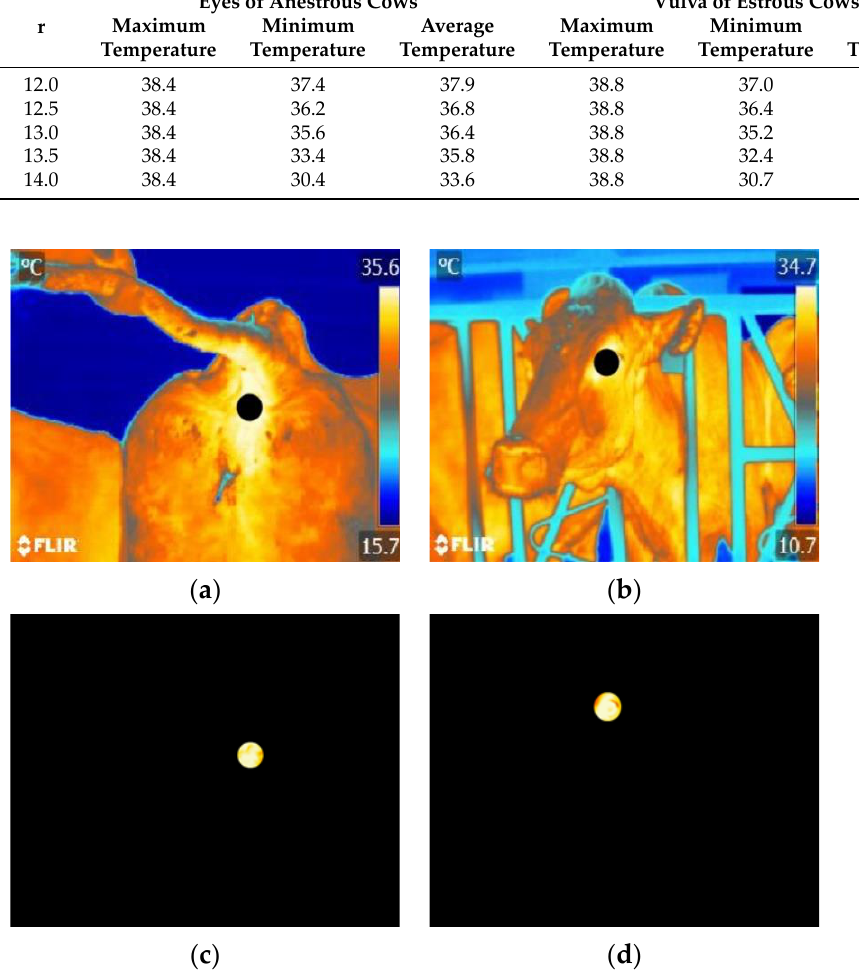
Figure 9. Infrared image feature map of the eye and vulva. ( a ) Marker map in the vulva, ( b ) marker map in the eye, ( c ) characteristic map of the vulva, and ( d ) characteristic map of the eye.